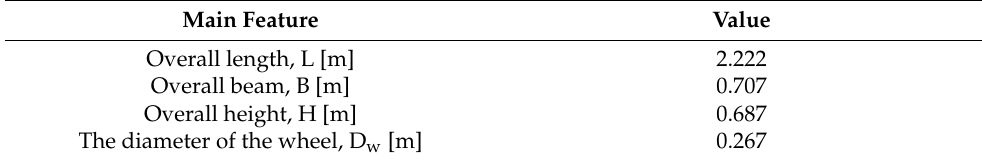
Table 1. Main parameters of the amphibious vehicle mode.